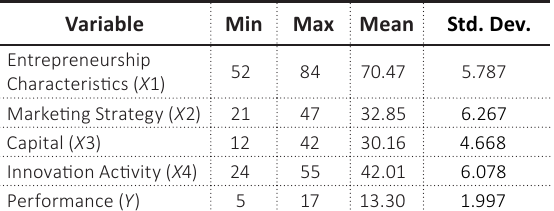
Table 1. Descriptive statistics of the main